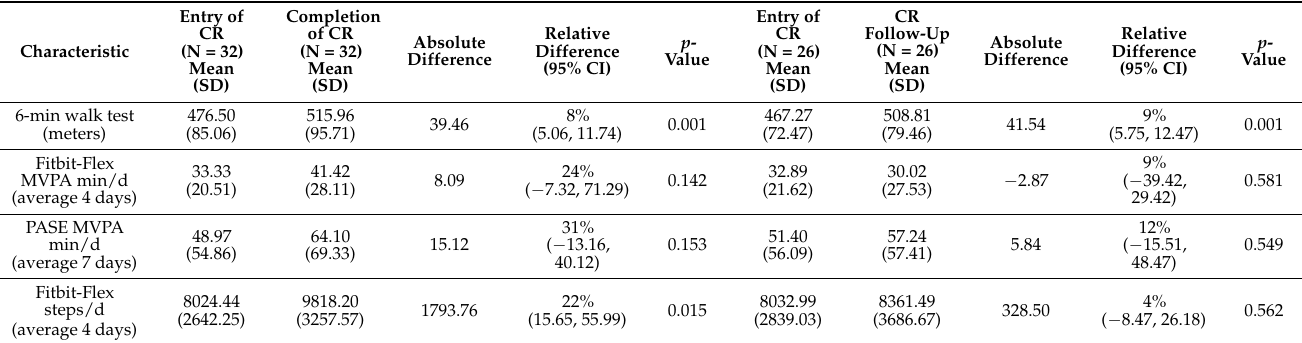
Table 1. Responsiveness of Fitbit-Flex, 6MWT and PASE at entry of CR, completion of CR, and CR